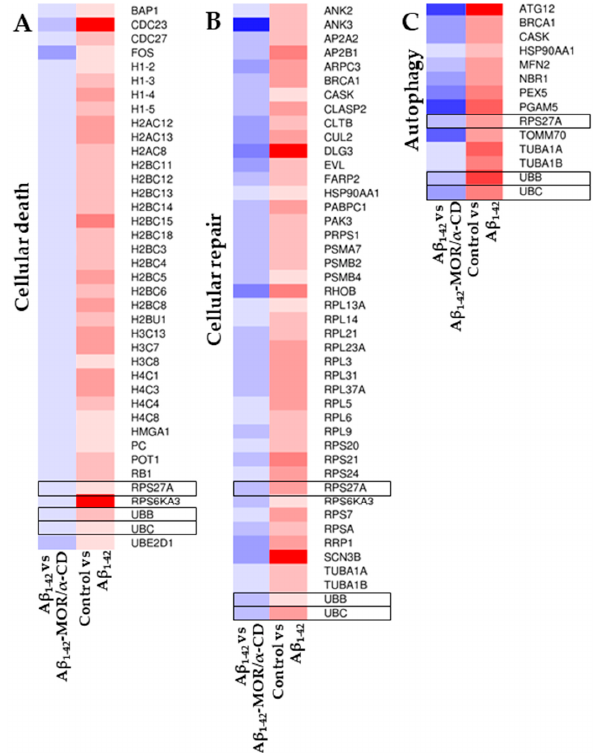
Figure 3. Heatmaps of the inspected DEGs. The heatmaps represent the DEGs found in Cellular Death” ( A ), “Cellular Repair” ( B ), and “Autophagy” ( C ) categories. The color scale goes from blue for the downregulated to red for the upregulated genes. By construction, all the genes in the left panel (A β 1-42 against A β 1-42 -MOR/ α -CD groups) are downregulated whereas all the genes in the right panel (control and A β 1-42 groups) are upregulated. In the black frame were highlighted the ubiquitins UBB , UBC , and RSP27A that are deregulated in all the categories.